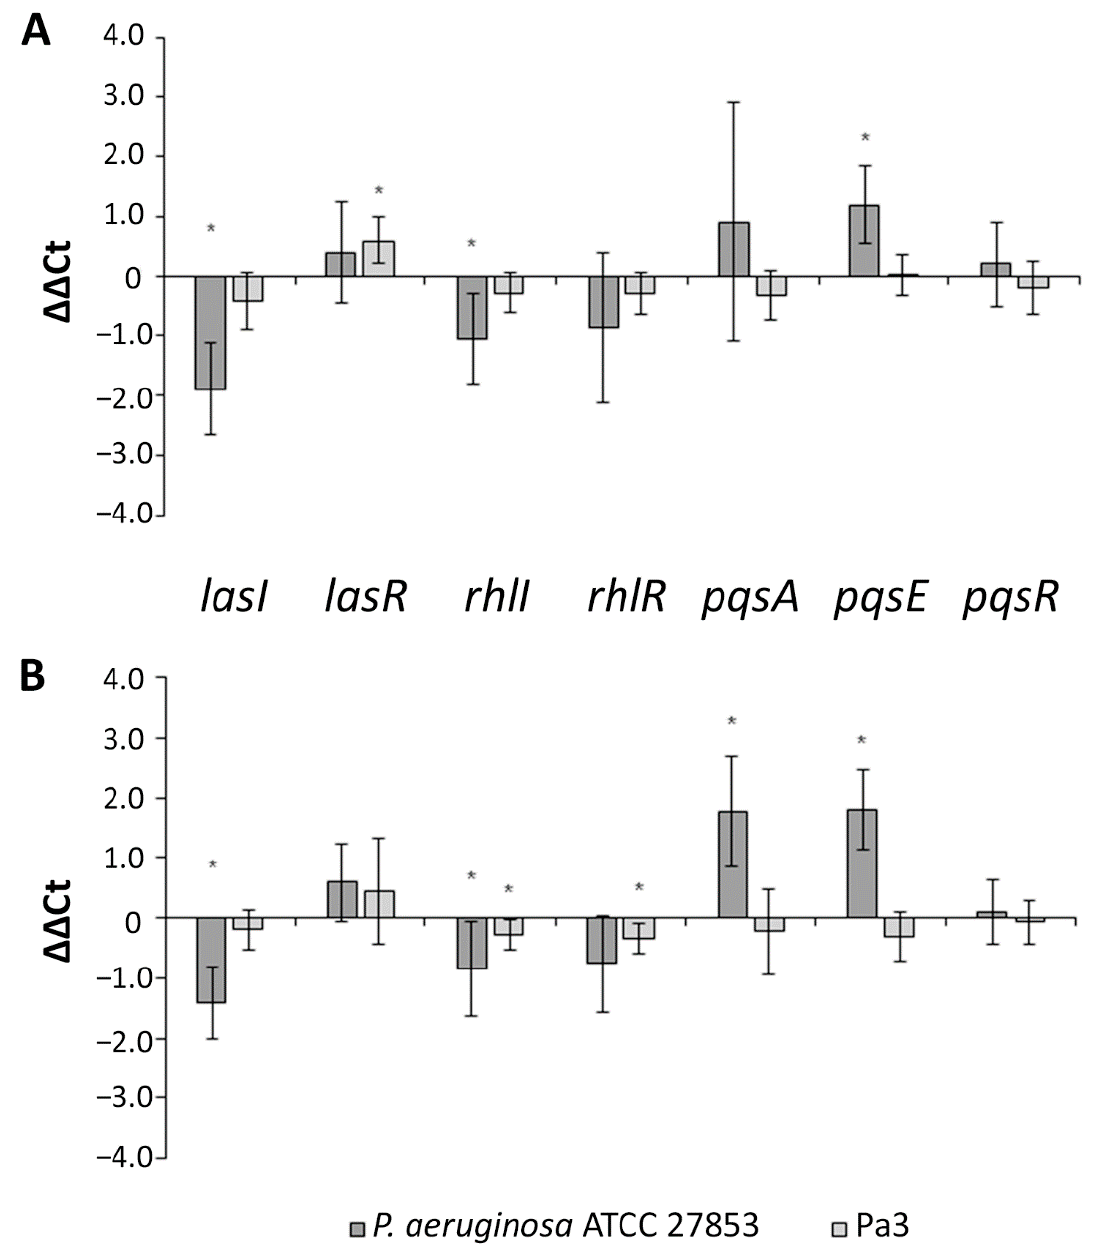
Figure 5. Relative quantification of the QS-related genes lasI , lasR , rhlI , rhlR , pqsA , pqsE , pqsR in P. aeruginosa ATCC 27853 and Pa3 biofilms formed in the presence of carboxypyrano-ant extract ( A ) or carboxypyCy-3-glc ( B ), at 64 µ g/mL. Results are expressed as ∆∆ Ct ± confidence interval at 95% confidence. Differences between the experimental group and the control (absence of extract or compound) were statistically significant (*) when the confidence interval does not contain the zero.